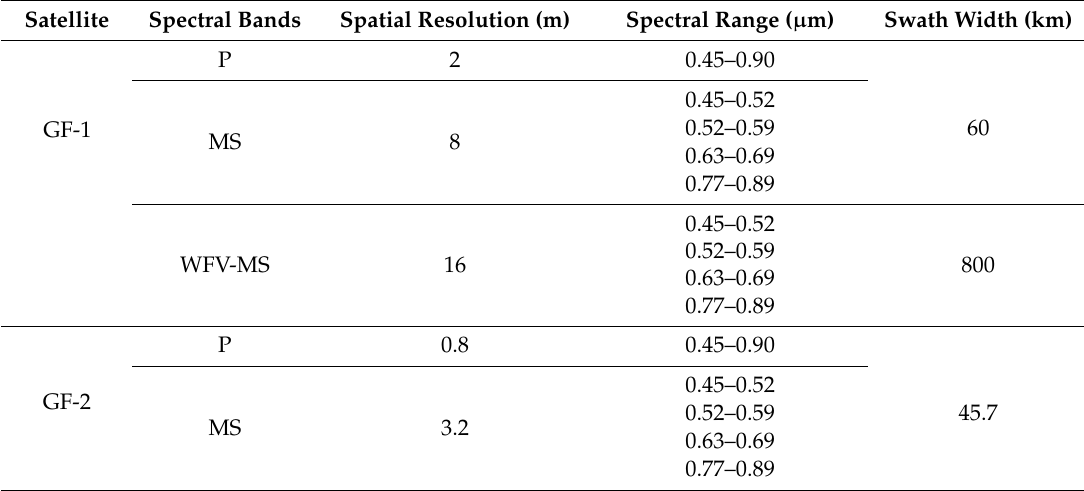
Table 1. Data characteristics for satellites GF-1 and GF-2.